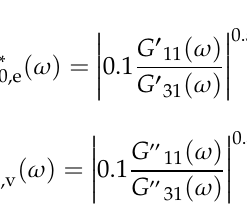
Figure 6. Plateau values of first-harmonic MAOS moduli at lower or higher frequencies ( G (cid:48) and G (cid:48)(cid:48) 31,p 31,p ) as a function of total molecular weight M w . Filled symbols indicate the values at a higher frequency. Unfilled symbols indicate the values at a lower frequency. The dashed line is drawn to guide the eye.